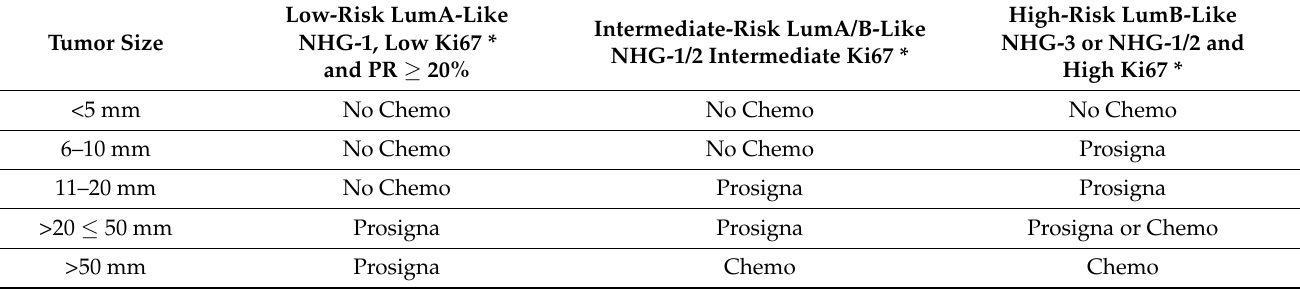
Table 1. Indication for Prosigna testing according to Swedish national guidelines from 2019 and adapted regionally. NHG; Nottingham Histologic Grade. * Pathology lab specific Ki67 limits; Karolinska, Södersjukhuset, St:Göran hospital low 0–14%, intermediate 15–22%, high 23–100%; Jönköping, low 0–11%, intermediate 12–21%, high 22–100%; Akademiska hospital, low 0–14%, intermediate 15–23%, high